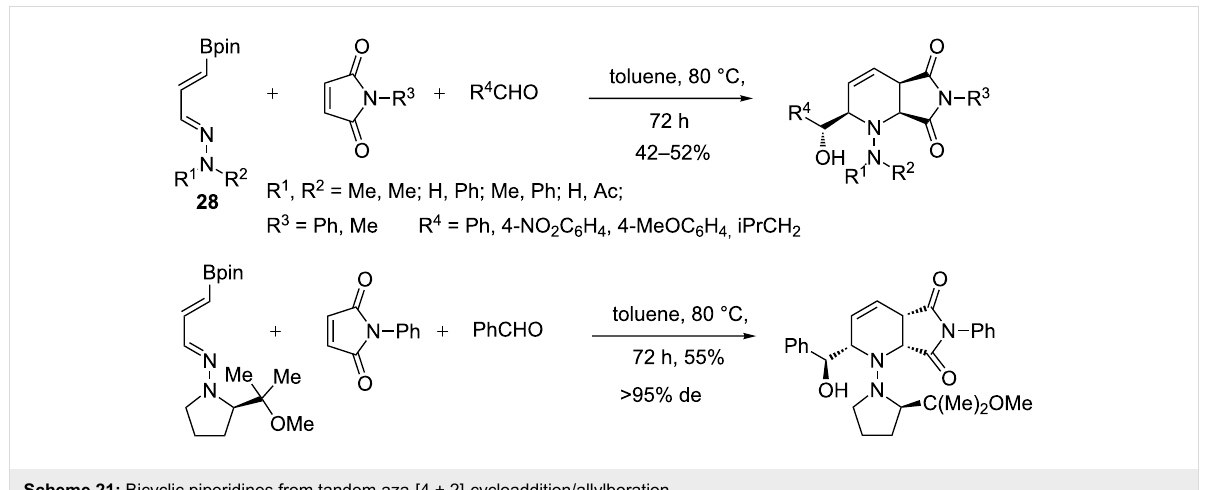
Scheme 20: Synthesis of an advanced intermediate 27 for the east fragment of palmerolide A.